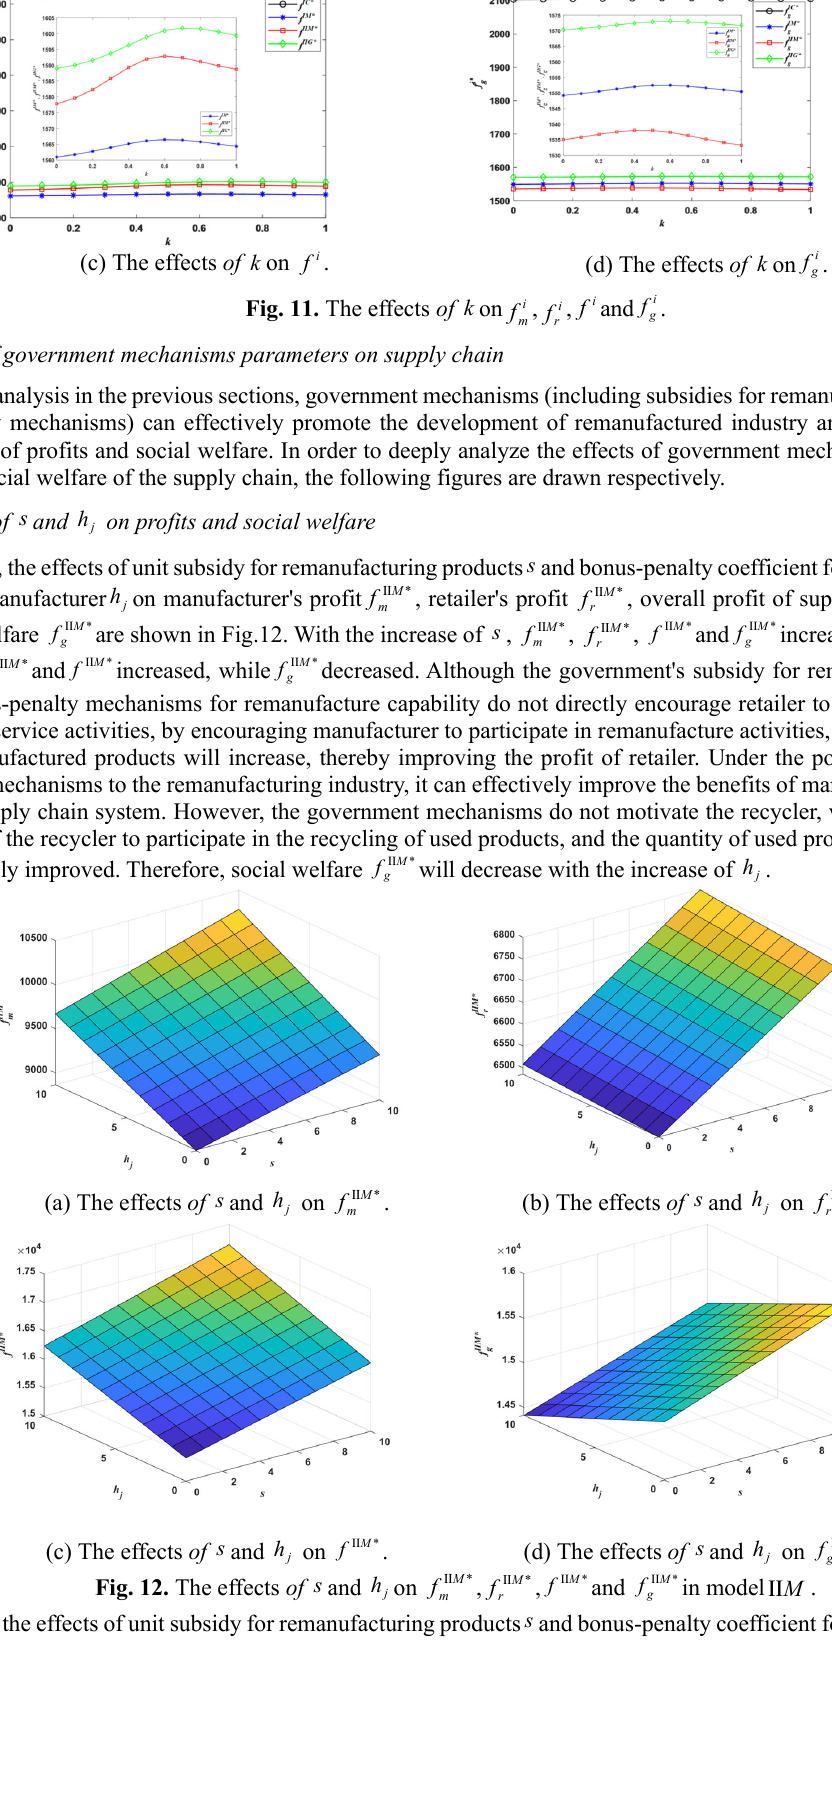
Fig. 11. The effects of k on i